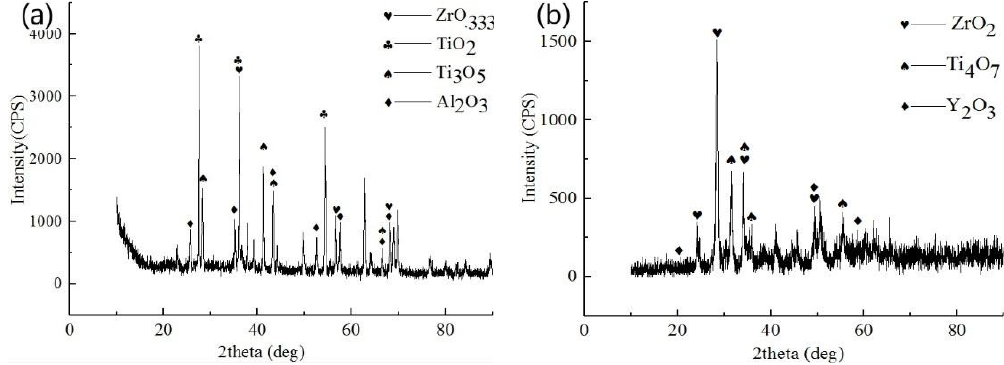
Figure 11. XRD pattern of the specimens at 850 °C for 100 h: ( a ) Zr coating; ( b ) Zr-Y coating.